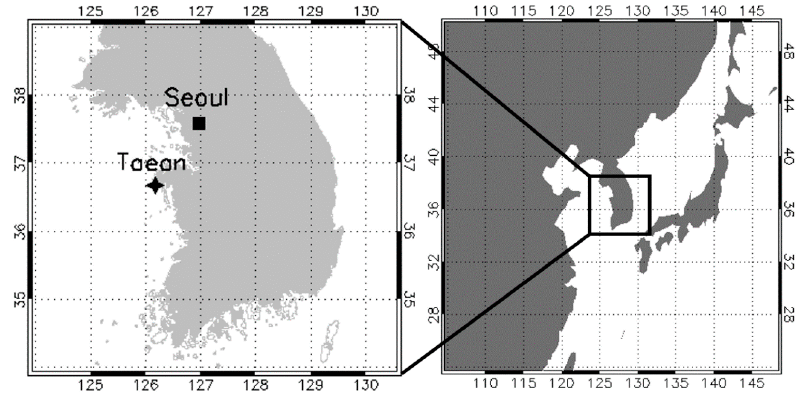
Figure 1. Map of Seoul and Taean locations of ceilometers. Solid square symbol is the Seoul (Seoul_S1 and Seoul_S2, 126.98° E, 37.58° N) station areas. Solid star is the Taean (Taean_S1 and Taean_S2, 126.29° E, 36.75° N) station areas.